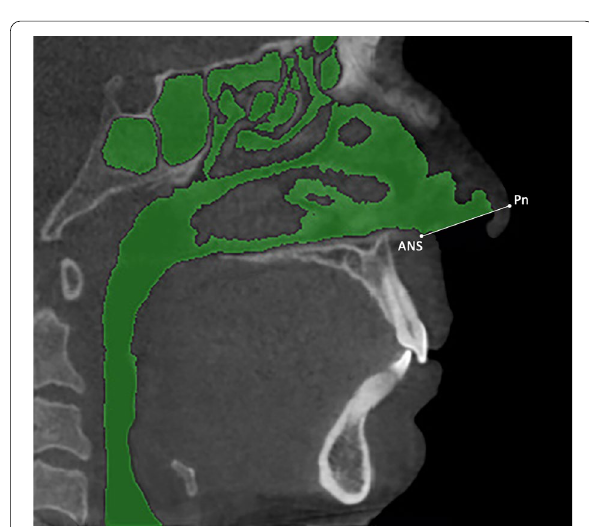
Fig. 3 Manual segmentation mask of the upper airway and landmarks of the cutting plane to exclude the lowermost area of the nostrils. ANS anterior nasal spine; Pn soft tissue Pronasal = =